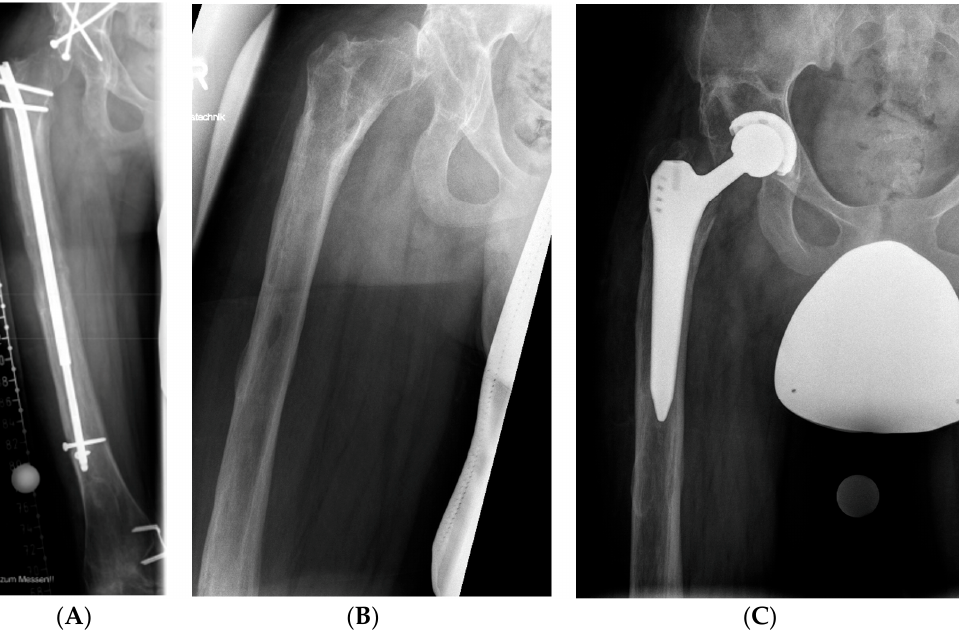
Figure 5. ( A , B ) Progressive lateralization of the femoral head during lengthening in a male patient with preexisting congenital femoral deficiency, despite prior attempts to improve hip containment by periacetabular osteotomy. ( C ) The patient ultimately received a total hip arthroplasty due to persistent pain and stiffness of the hip joint.